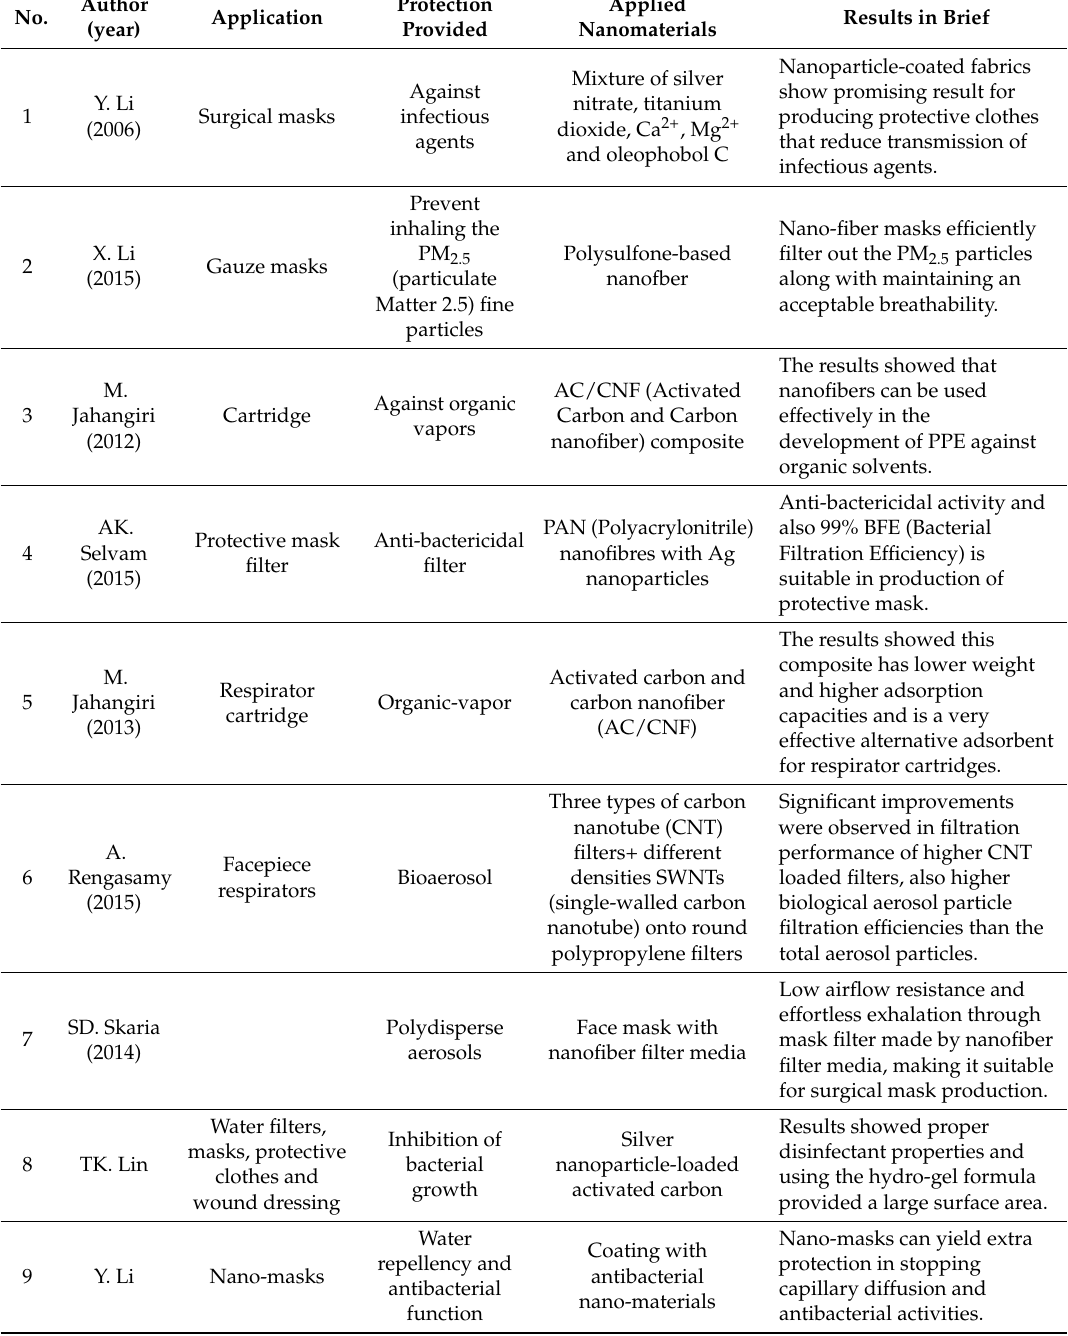
Table 1. The summary of study